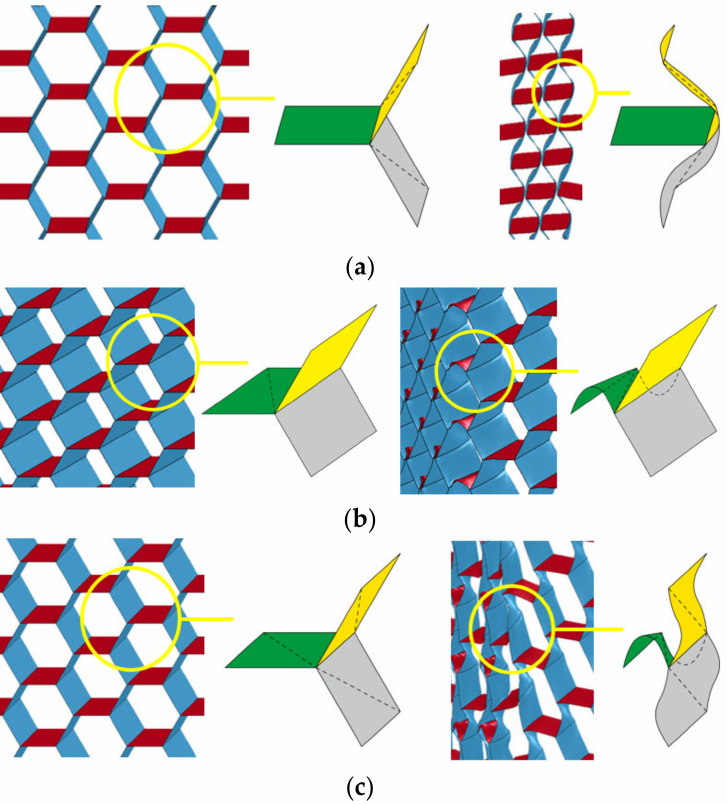
Figure 8. Y-cellular in ( a ) symmetric deformation pattern; ( b ) one-sided deformation pattern; and ( c ) compound deformation pattern.